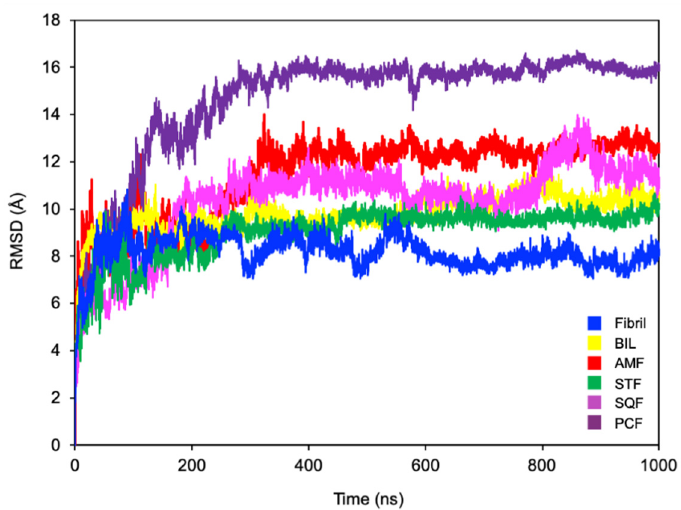
Figure 5. Comparative all atom RMSD for ligand-free and ligand-bound simulations using the equilibrated structure for each simulation as the reference structure. Simulations were performed with A β 42 alone (Fibril) or in the presence of bilobetin (BIL), amentoflavone (AMF), sotetsuflavone (STF), sequoiaflavone (SQF), and podocarpusflavone (PCF).